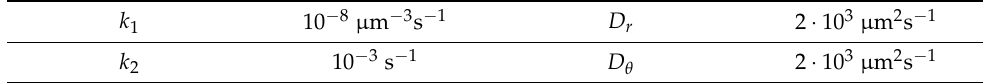
14 of 19 Table 4. Simulation 4: constants and coefficients.